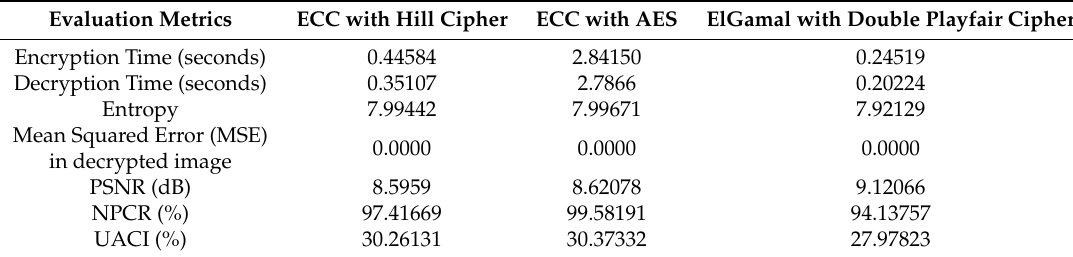
Table 4. Metric measures for Mona Lisa (gray).